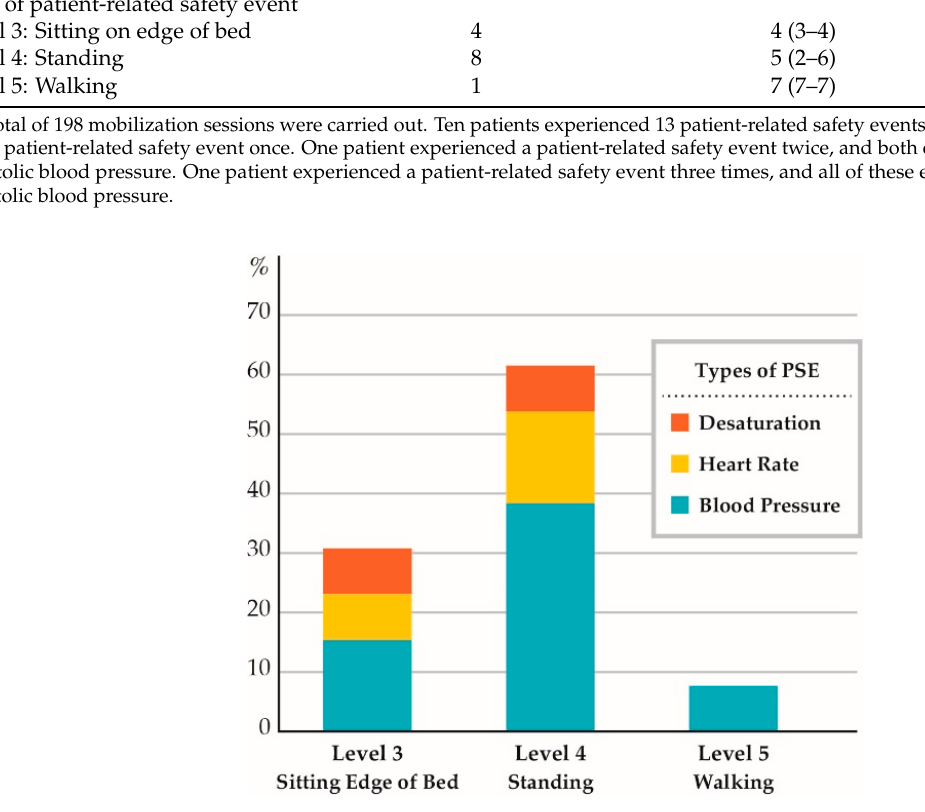
Figure 2. Occurrence rate of patient-related safety events (PSE) classified by mobility level. Table 3. Types and timing of patient-related safety events. Table 4. Risk factors for the occurrence of patient-related safety